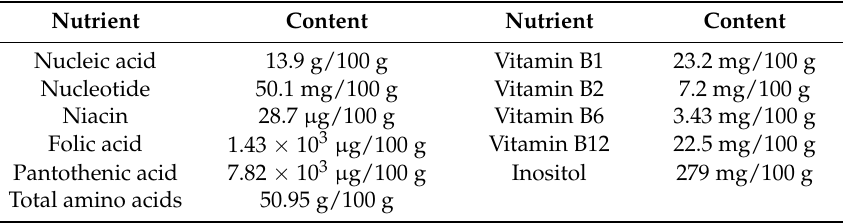
Table 1. The nutritional contents of the yeast